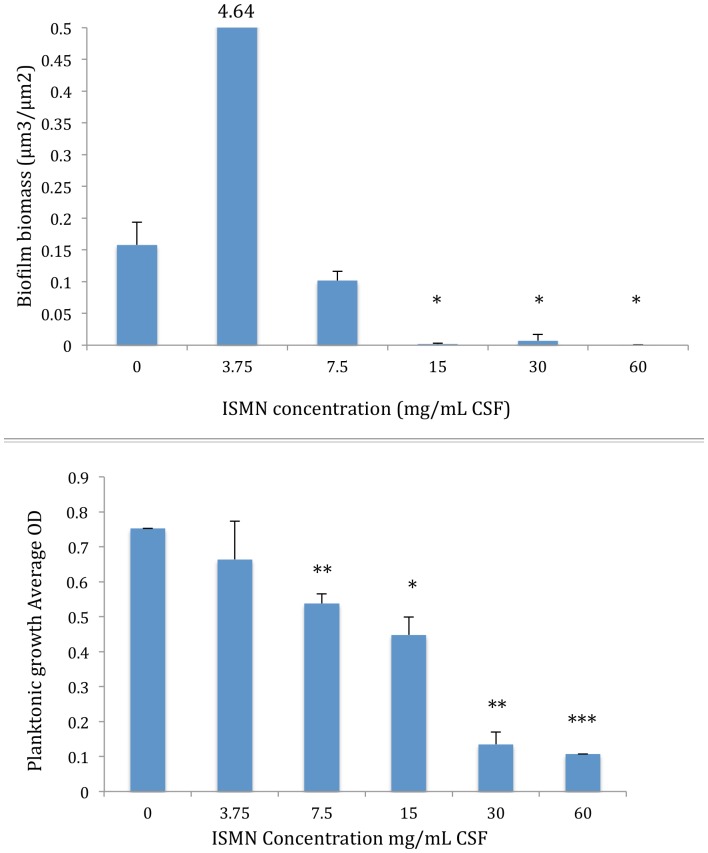
Dose-response of pure ISMN on S. aureus biofilm biomass (A) and planktonic cell growth (B).4.64 is the biofilm biomass at 3.75 mg/mL ISMN concentration. ISMN: Isosorbide mononitrate. Data represents Mean +/– SD of a duplicate experiment. *, P<0.05; **, P<0.01, ***, P<0.001 compared to untreated control; Two-tailed t test.